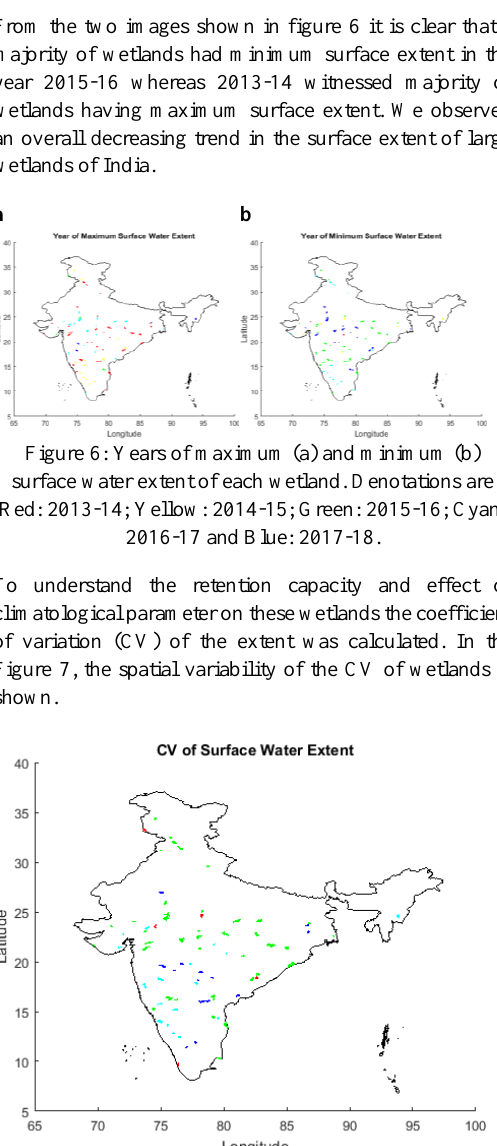
Figure 7: Illustration of Coefficient of Variation(CV). CV< µ-σ in Red, µ-σ <CV< µ in Green, µ<CV< µ+σ in Cyan and CV> µ+σ in